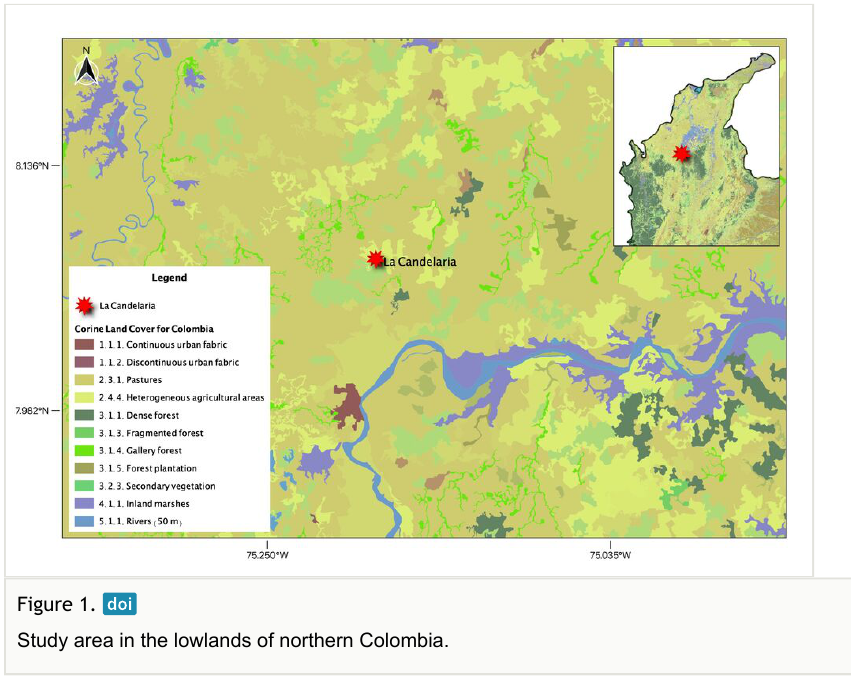
Study area in the lowlands of northern